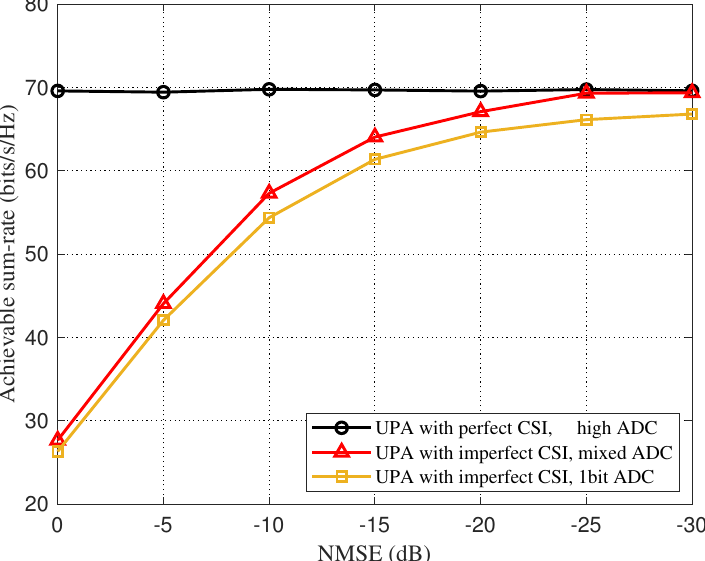
Figure 6. Total rate for beam selection against different NMSE for the beamspace channel estimation.